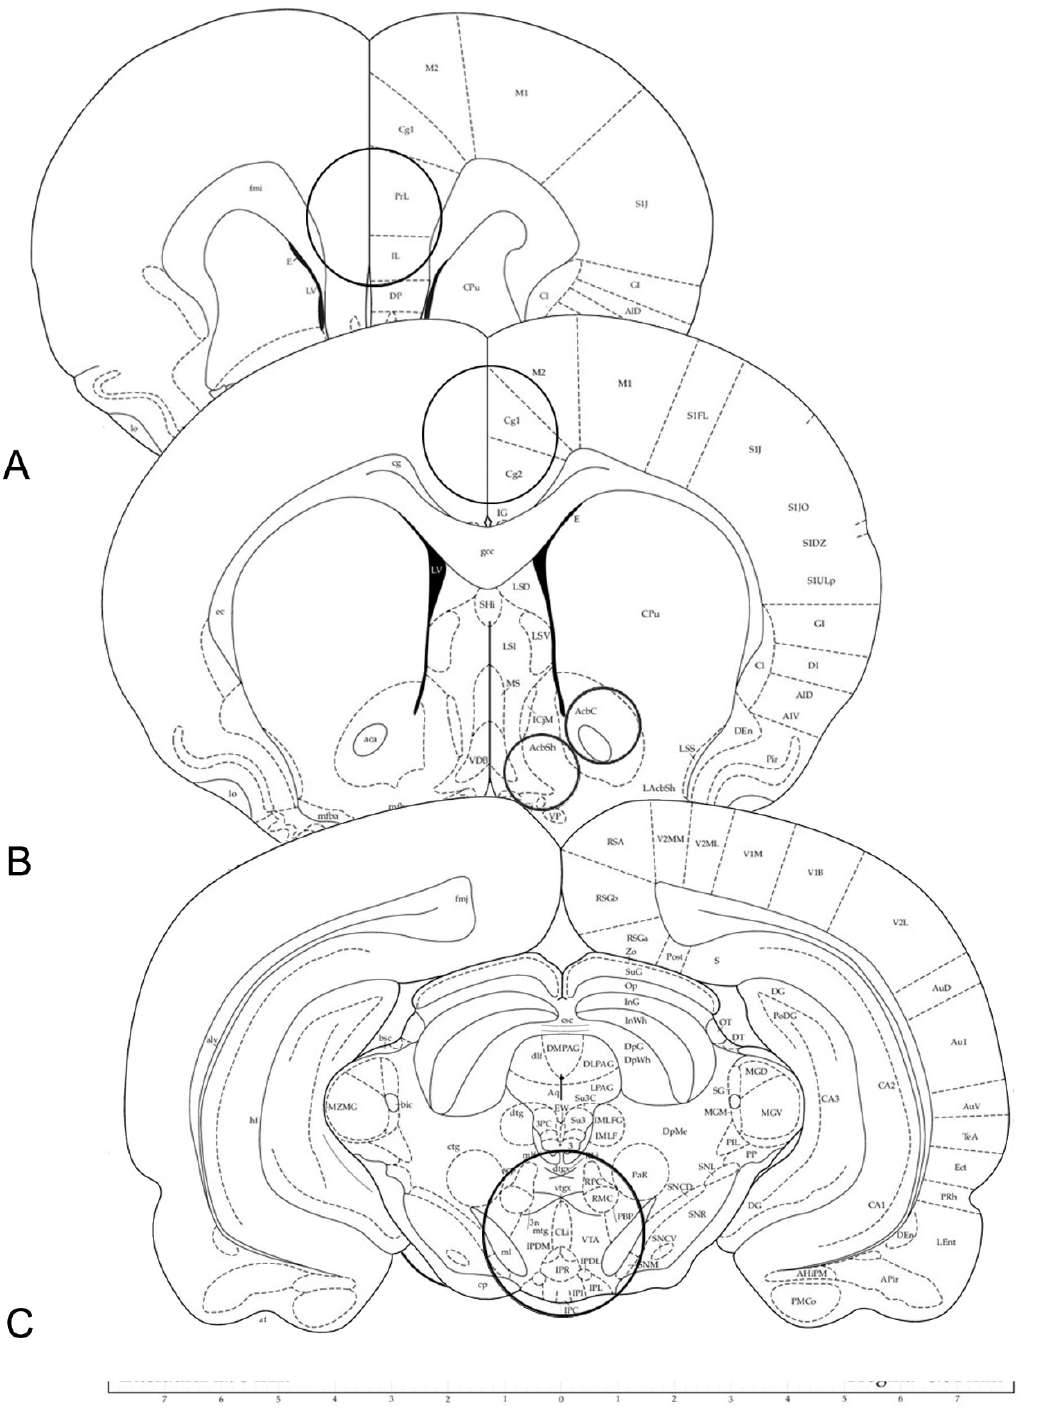
Figure 13. Schematic representation of rat brain coronal sections (plates Nr. 10, 14 and 44 adapted from Ref. [54]. Copyright © 1997 by George Paxinos and Charles Watson). The circles in ( A – C ) denote the areas of infra-limbic (IL) and pre-limbic (PL) regions of the medial prefrontal cortex ( A ); the cingulate cortex, the shell (AcbSh) and core (AcbC) subregions of the nucleus accumbens ( B ); the ventral tegmental area (VTA) ( C ); taken for western blot analysis using micropunches of 2.5 mm ( A ), 2.5 mm and 1.5 mm ( B ), and 3 mm ( C ).